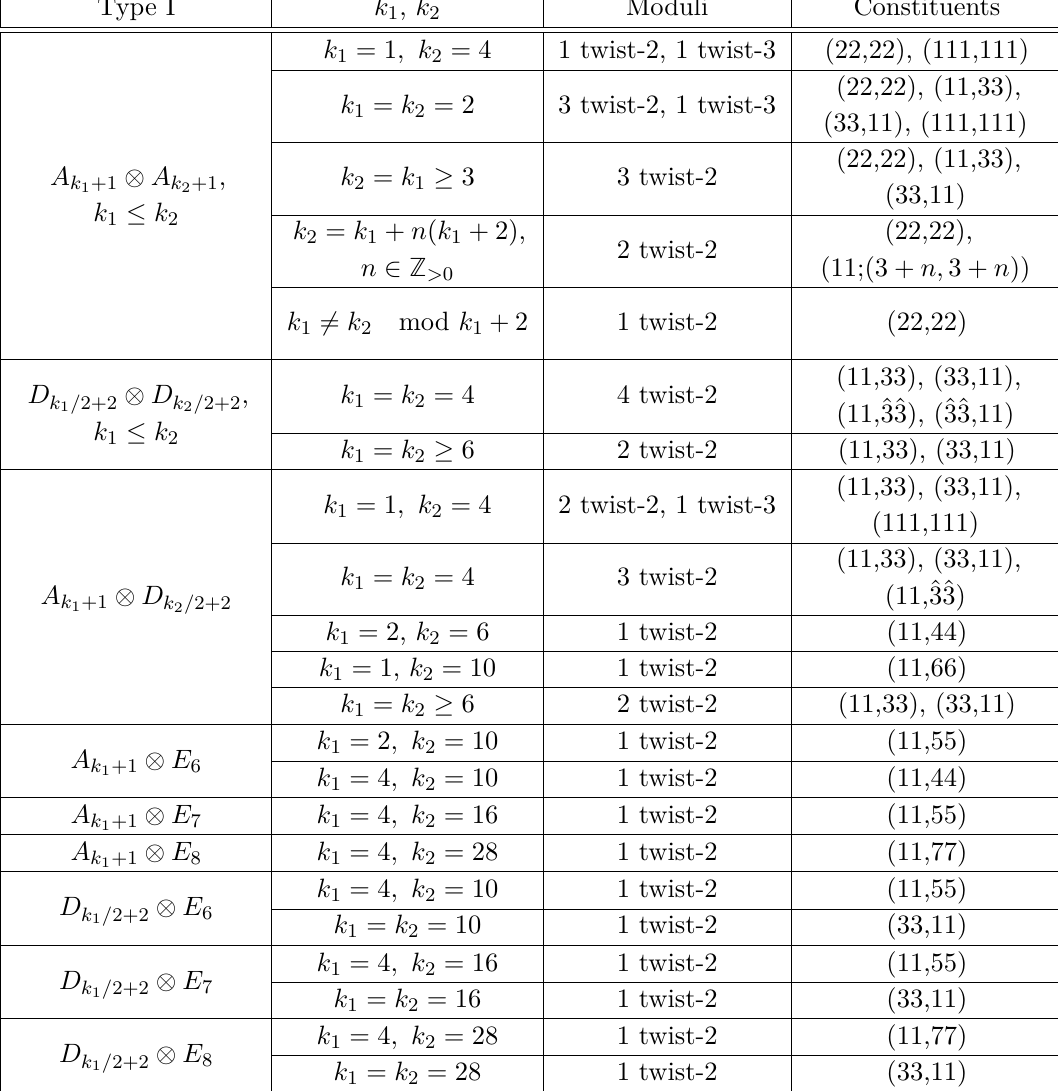
Table 1 . Overview of the different single-trace twisted operators for sparse theories with two minimal models in the tensor product. Details on the notation can be found in appendix